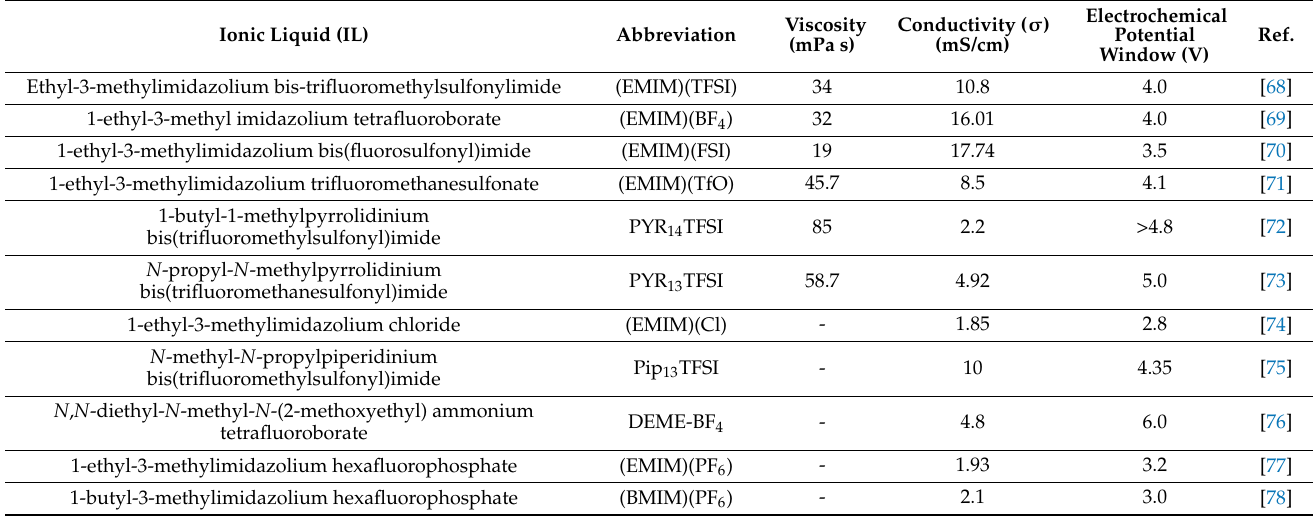
Table 1. Few important IL-based electrolytes for EES applications are reported in the literature. Ionic Liquid